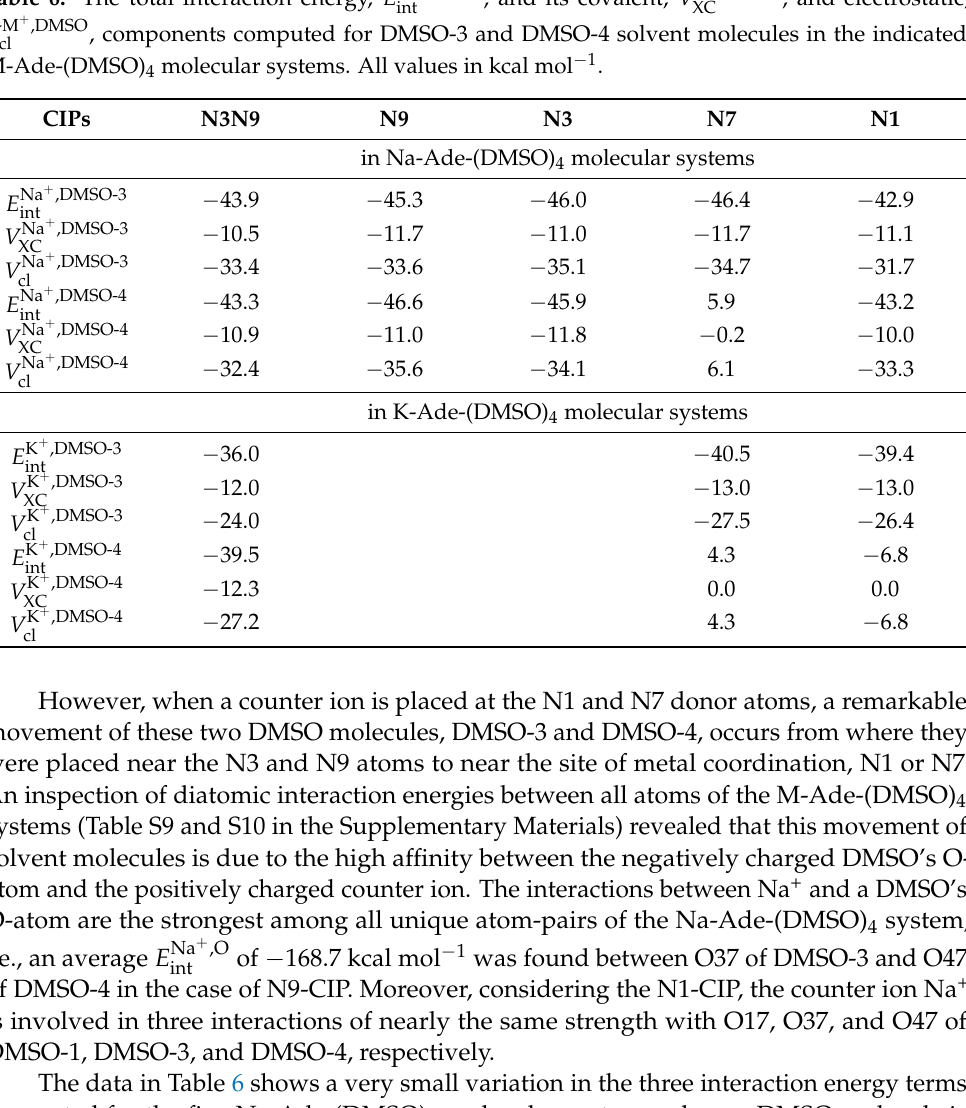
+ ,DMSO + ,DMSO , and its covalent, V M , and electrostatic, int XC